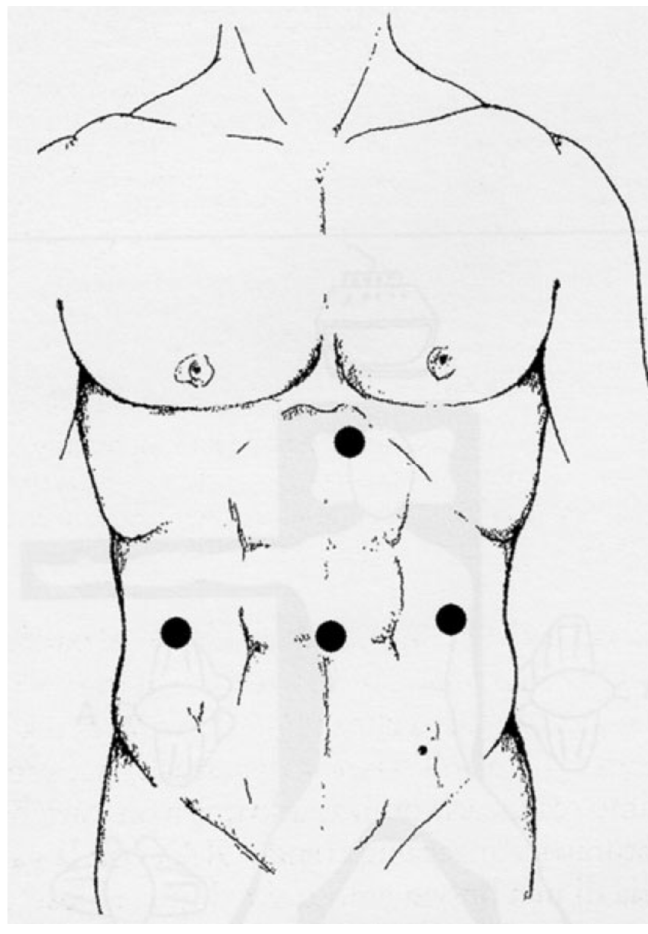
Figure 2. Trocar placement for laparoscopic gastrectomy.